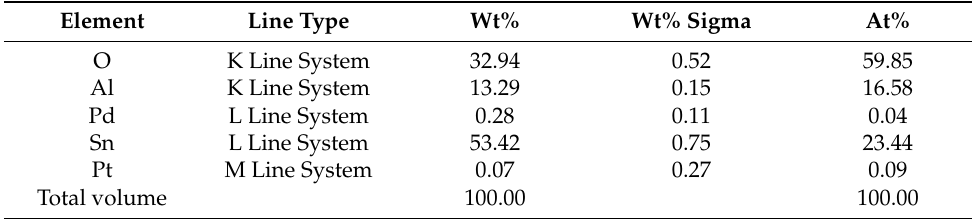
Figure 4. Total spectrum of Pd – Pt/SnO 2 /Al 2 O 3 thin films with elemental distribution. Table 1. Total distribution spectral chart elemental content analysis table.